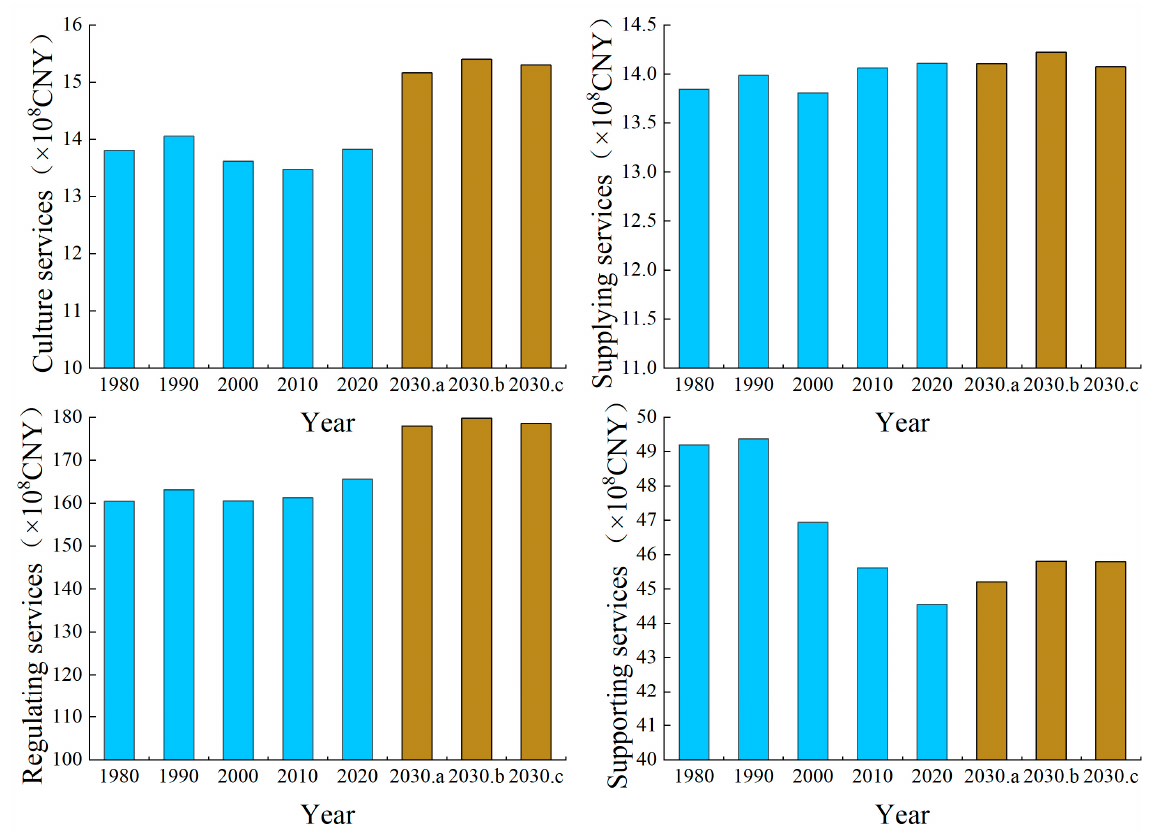
Figure 7. Changes in ESVs for supplying services, regulating services, supporting services, and cul- tural services from 1980 to 2030. (Note: a, b, and c indicate ND, EPD, and EED scenarios, respec- tively).